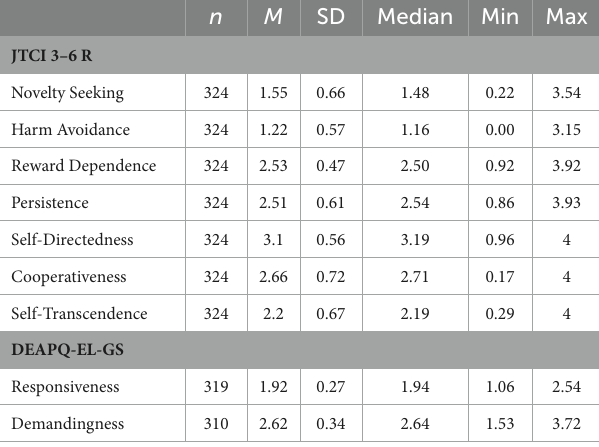
TABLE 1 Descriptive statistics of personality and parenting behavior.